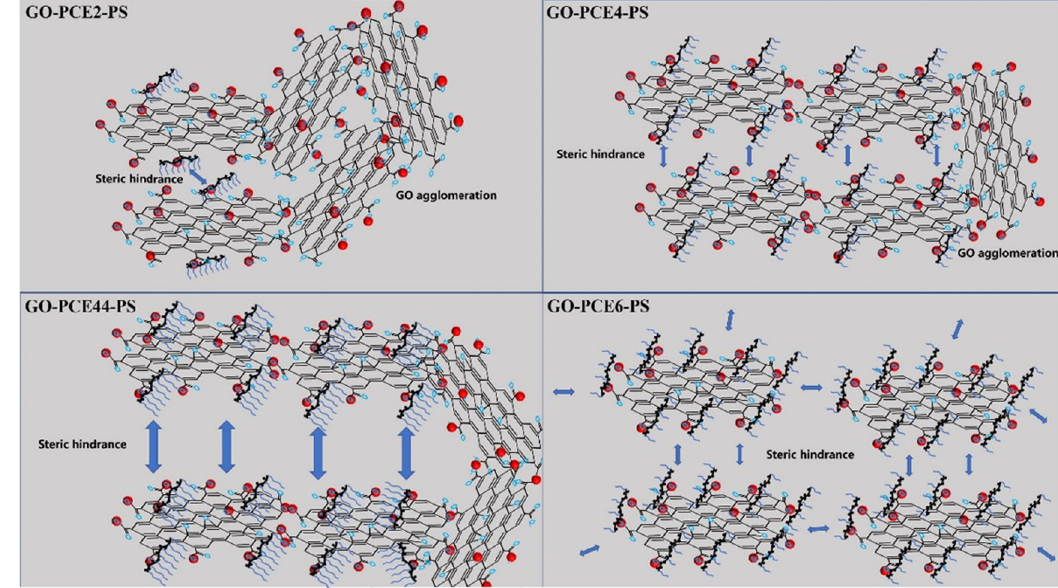
Figure 5: Mechanism of improved dispersion by GO – PCE in the cement pore solution [ 49 ]